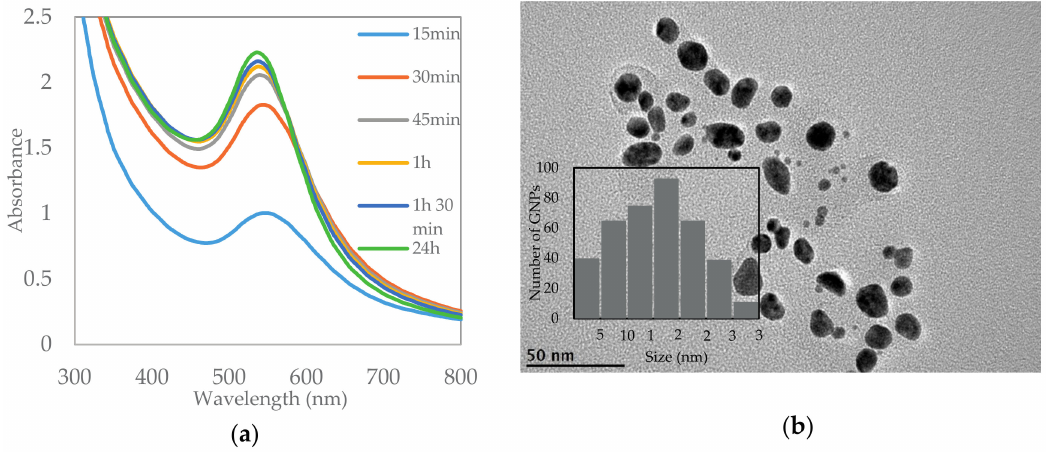
Figure 1. ( a ) Ultraviolet-visible (UV-Vis) spectra of gold nanoparticles (AuNPs) at incubation times of 15, 30, 45, 60, and 90 min and 24 h; ( b ) Transmission electron micrographs of AuNPs synthesized from Curcuma mangga (CM) extract at magnification 100,000 × . (Inlet) Size distribution of AuNPs analyzed for about 400 particles using Image